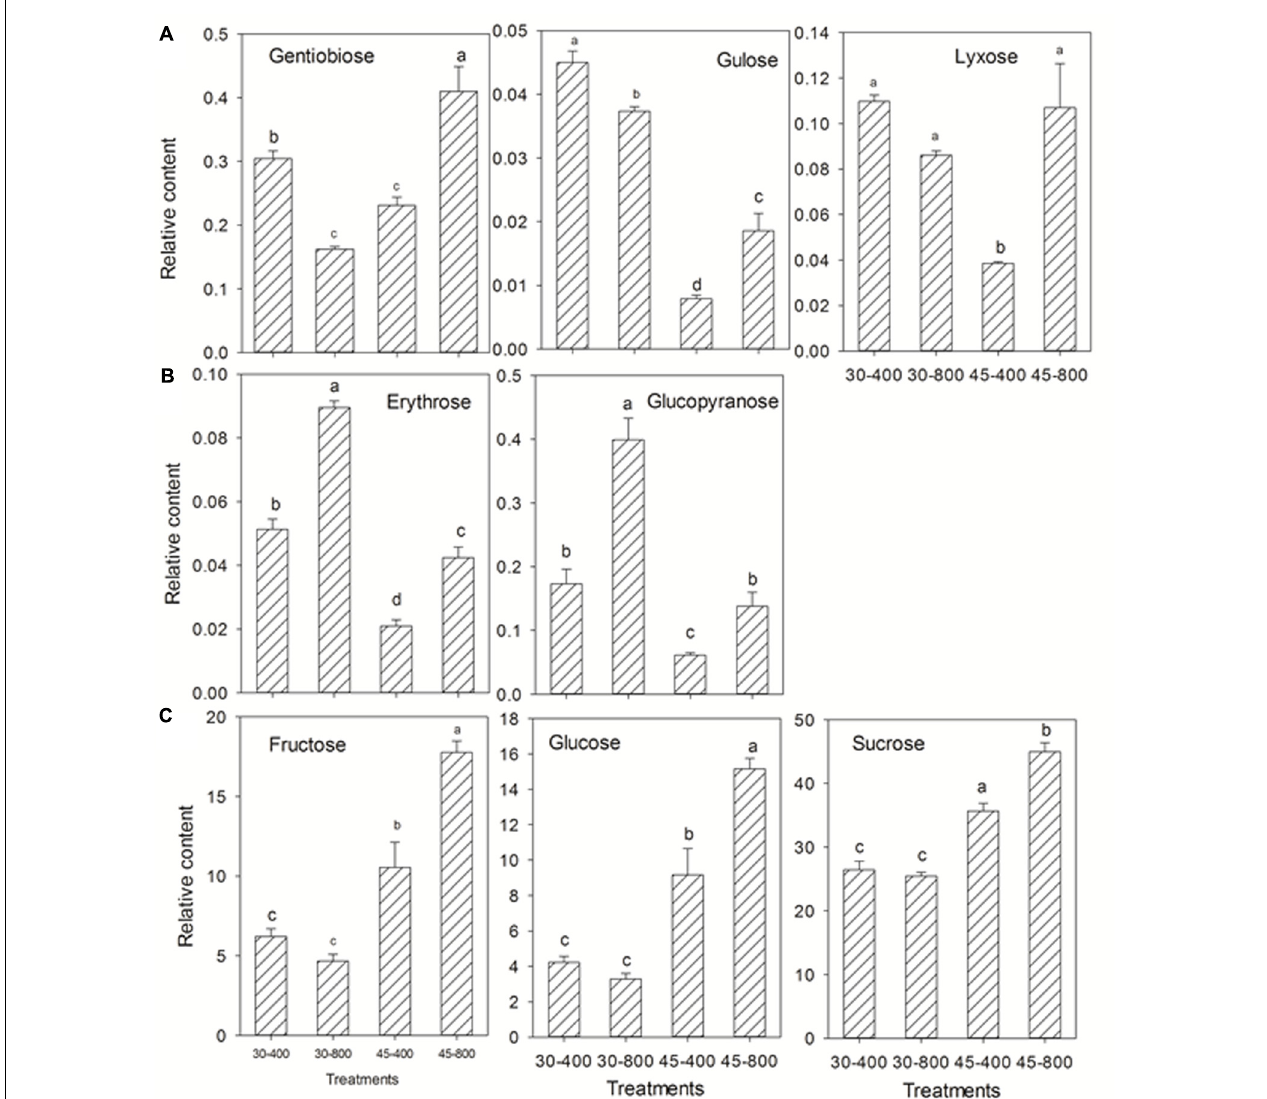
FIGURE 6 | Effects of elevated CO 2 concentration on sugars in response to heat stress in bermudagrass. The treatments symbols are 30 and 45 for normal temperature control and heat stress and 400 and 800 for ambient CO 2 and elevated CO 2 concentrations, respectively. (A) Down-regulation or no changes under 30–800 and down-regulation under 45–800; (B) Up-regulation under both 30–800 and 45–800; (C) No changes under 30–800 and up-regulation under 45–800. Columns marked with different letters presented the significant differences based on LSD values ( P ≤ 0.05) among